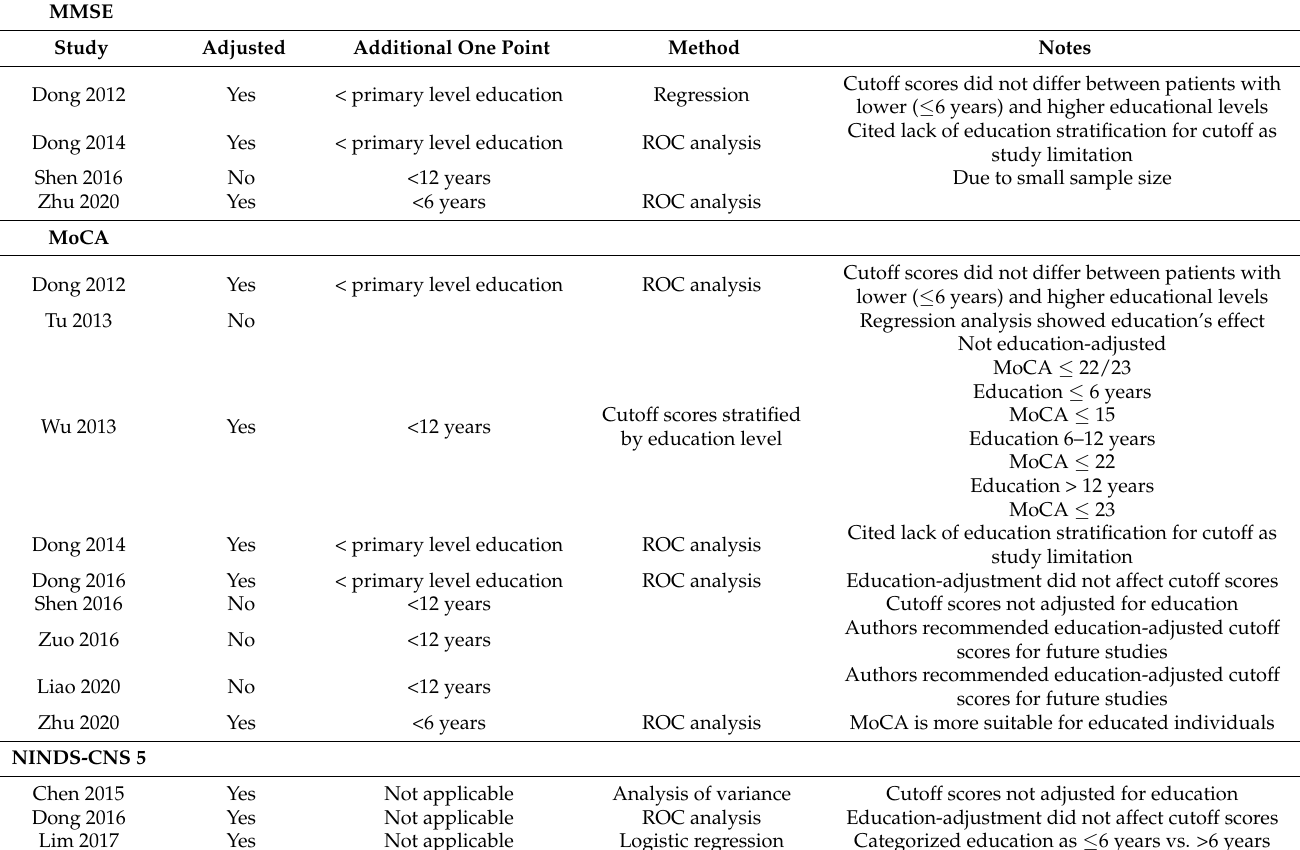
Table 2. Methods for education adjustment across